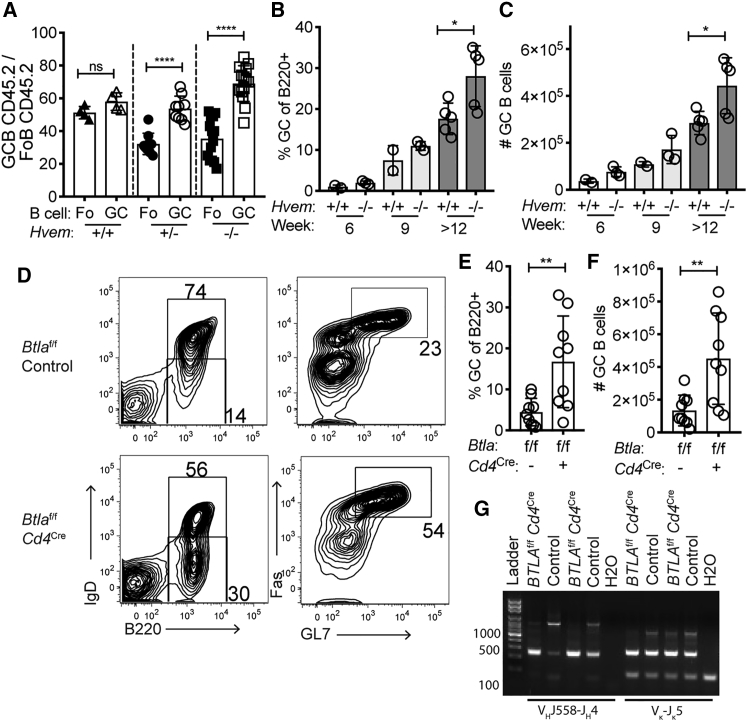
BTLA Deficiency in T Cells Leads to GC B Cell Expansion in the Setting of Bcl-2 Overexpression(A) Frequency of CD45.2 splenic Fo and GC B cells of Bcl-2 transgenic origin in mixed BM chimeras reconstituted with 30%–50% Hvem+/+, Hvem+/−, or Hvem−/− Eμ-BCL2-tg CD45.2 BM and 50%–70% WT Eμ-BCL2-tg CD45.1/2 BM at day 7 after SRBC immunization. Data are pooled from three experiments.(B and C) The frequency (B) and number (C) of spontaneously forming splenic GC B cells in mice reconstituted for 6–14 weeks with Hvem+/+or Hvem−/− BM transduced with MSCV-Bcl2-Thy1.1. Data are pooled from two experiments.(D) Representative flow-cytometric analysis of spontaneous GC formation in the spleen after 8 weeks of reconstitution with Btlaf/f or Btlaf/fCd4Cre BM transduced with MSCV-Bcl2-Thy1.1. Irradiated Rag2−/− or Tcrb−/− mice were used as hosts.(E and F) The frequency (E) and number (F) of spontaneously forming splenic GC B cells in BM chimeras from (D). Data are pooled from three experiments.(G) VH- and VL-region PCR analysis of GC B cells from two Btlaf/fCd4Cre chimeras with splenic GC outgrowths > 20% and two Btlaf/f control chimeras.Unpaired two-tailed Student’s test (B,C, E, and F): ∗p < 0.05, ∗∗p < 0.01, ∗∗∗∗p < 0.0001.